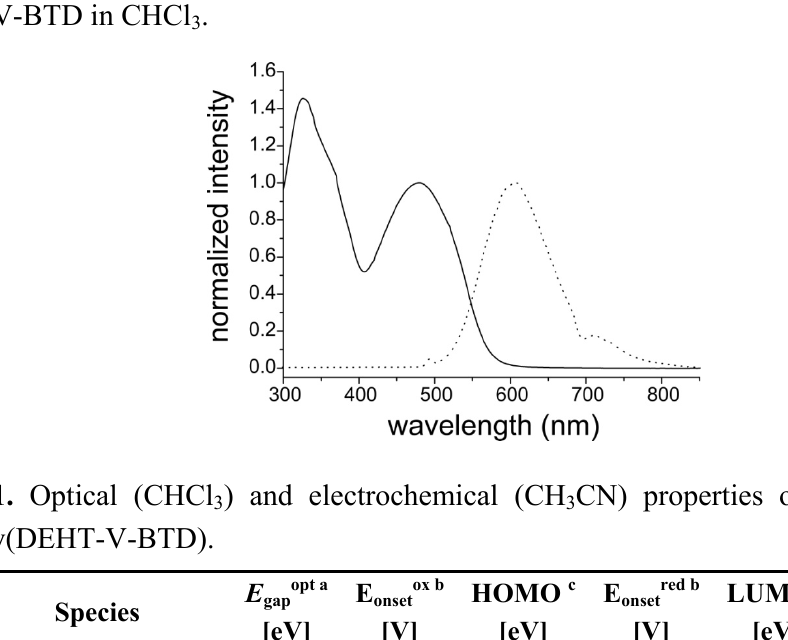
Figure 3. Absorption (continuous line) and emission spectra (dashed line) of monomer DEHT-V-BTD in CHCl . 3